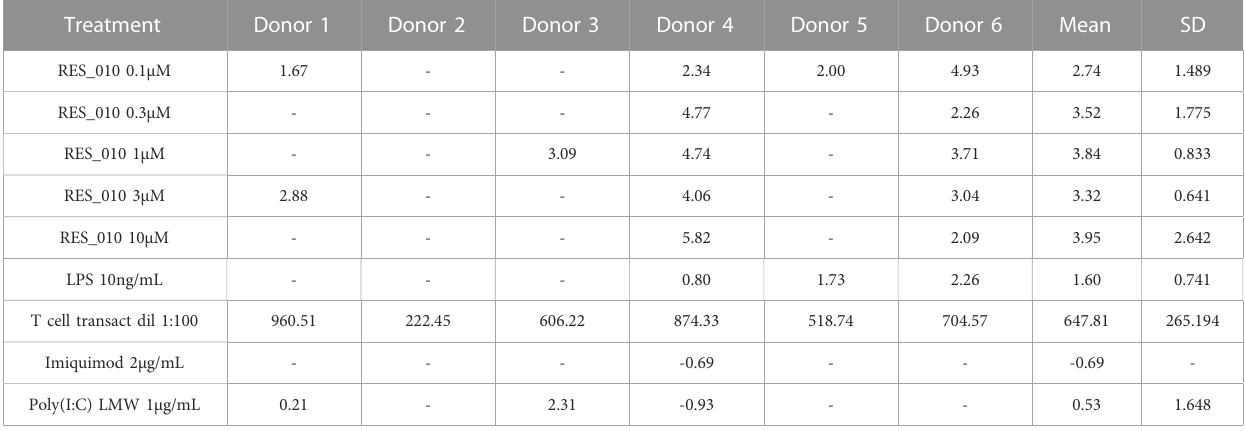
TABLE 8 Concentration Data Vehicle Corrected (pg/mL) for Cytokines: IL-17A.